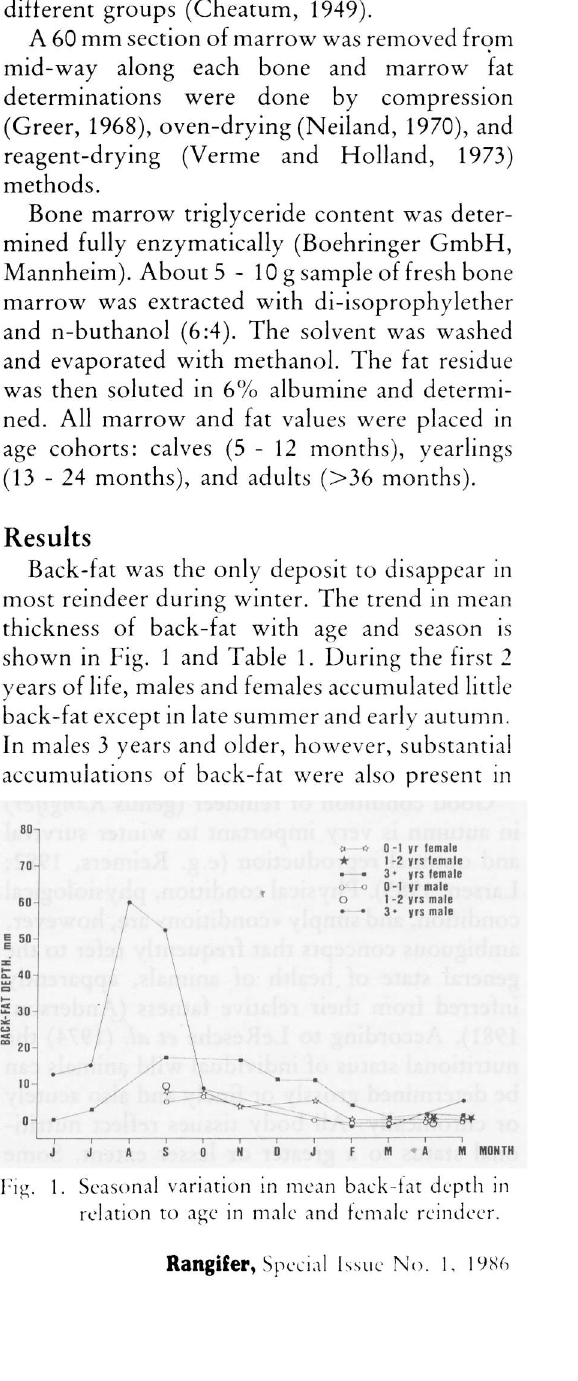
7 ig. 1. Seasonal variation in mean back-lat depth in relation to age in male and female